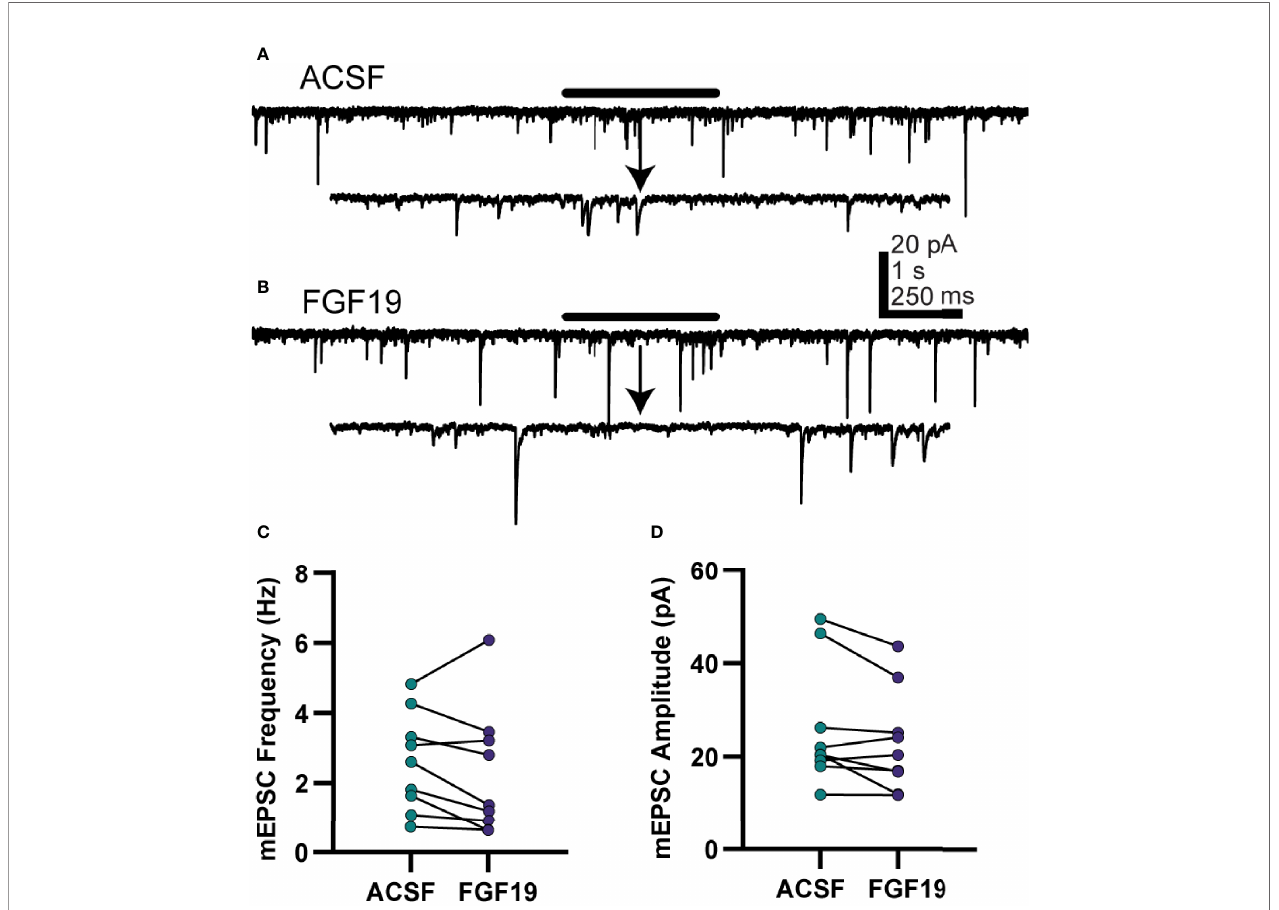
FIGURE 4 | FGF19 does not alter mEPSC frequency in NTS neurons from hyperglycemic mice. (A, B) representative voltage clamp recordings in NTS neurons from T1DM mice in the presence of TTX (2 µM). (C) FGF19 failed to alter mean mEPSC frequency (n = 9; p > 0.05). (D) FGF19 failed to alter mean mEPSC amplitude (n = 9; p > 0.05). All cells recorded at -85 mV. Paired t-test used for all analyses. All recordings performed in TTX (2